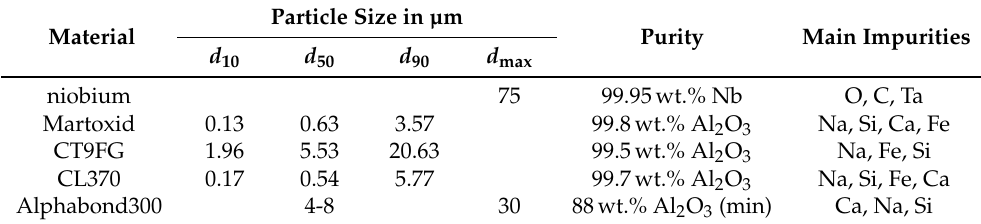
Table 1. Determined particle sizes of the used raw materials and their chemistry.